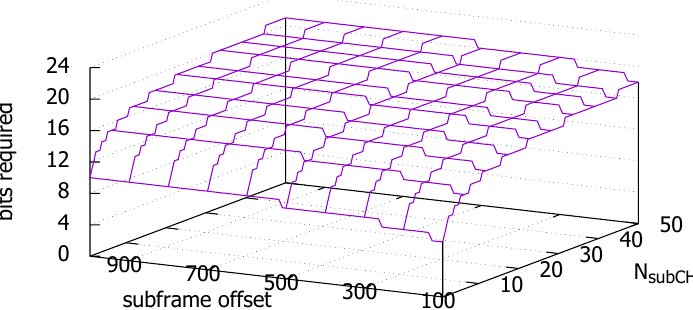
Figure 5. Number of additional bits to include the lookahead in the SCI Format 1, including the ten offset bits to the subframe in the